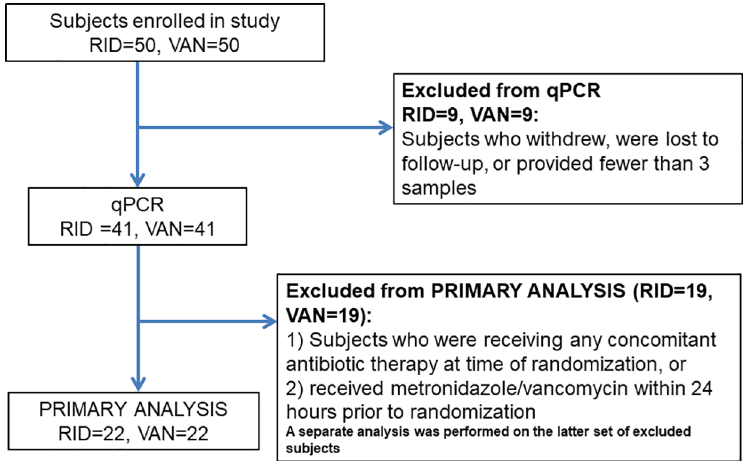
Fig 1. Consort diagram for participant inclusion in the nested cohort. Abbreviations: RDZ, ridinilazole; VAN, vancomycin.